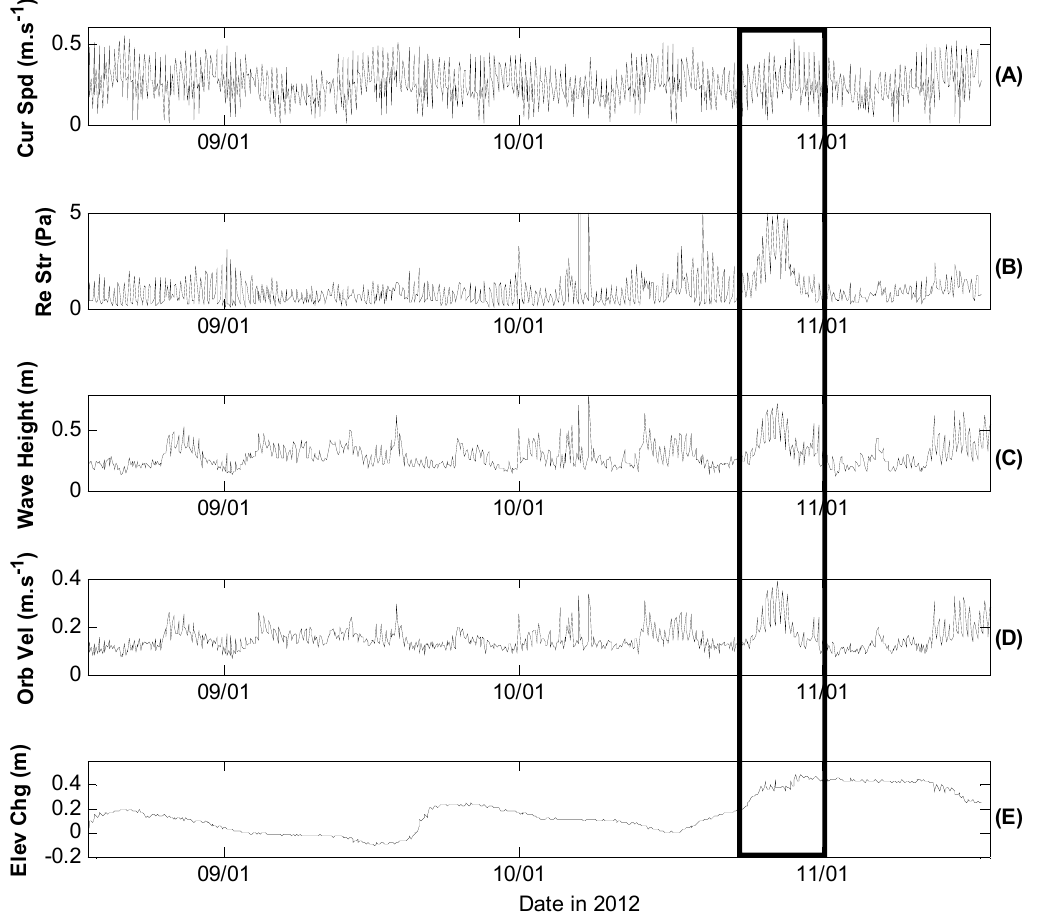
Figure 5. Data collected using an acoustic Doppler velocimeter (ADV) from B1 site between August 18 and December 18, 2012. ( A ) Horizontal current speed, ( B ) Reynolds Stress, ( C ) wave height, ( D ) near-bed wave orbital velocity, and ( E ) seabed elevation change. The rectangle highlights the passing of Hurricane Sandy in late October 2012.